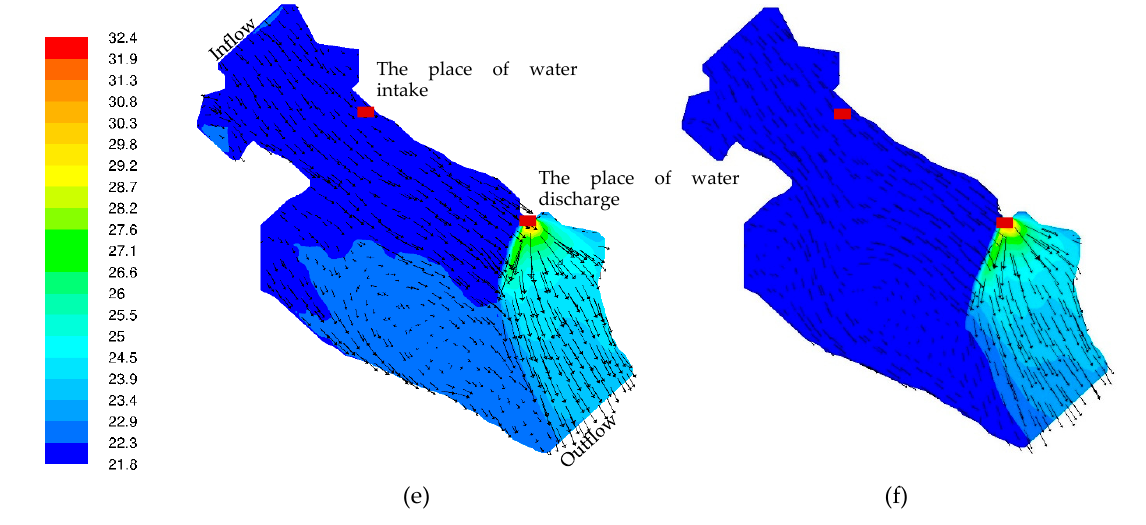
Temperature fields in the surface layer for northwesterly wind 8 m/s. Figure 13. Temperature fields for Wind SE 8 m / s for 95 H. ( a , c , e )—under the influence of a discharge Figure 13. Temperature fields for Wind SE 8 m/s for 95 H. ( a , c , e) —under the influence of a discharge from HEPP, regular mode in a changing discharge of water; ( b , d , f )—under minimum influence of a from HEPP, regular mode in a changing discharge of water; ( b , d , f) —under minimum influence of a discharge from HEPP, continuous discharge discharge from HEPP, continuous discharge mode.